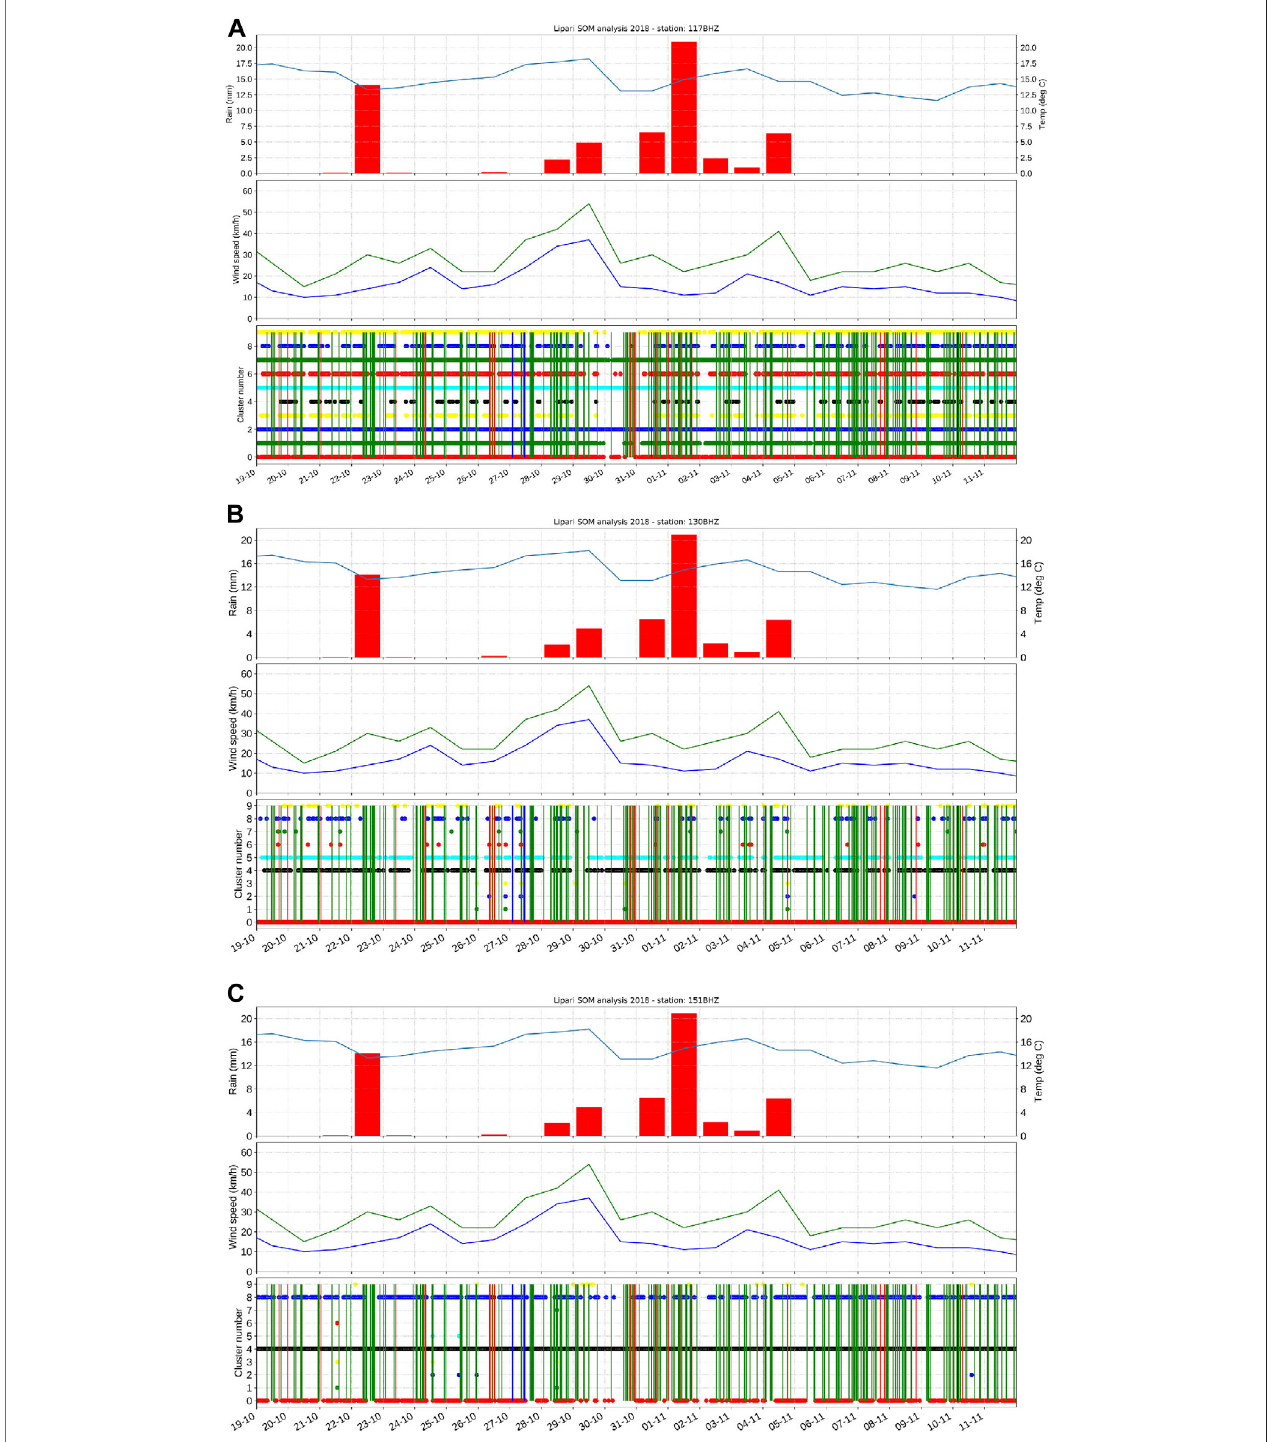
FIGURE 4 | 1-min long frames for stations 117 (top), 130 (middle) and 151 (bottom). Time evolution (horizontal axis) shows coherent appearance and disappearance of clusters, indicated by the number on the vertical axis. Cluster colors are only used to facilitate following their time evolution. Note the “ anomalous ” period of 30 October – 1 November 2018, where frames are mostly classi fi ed in only a few clusters. Cluster numbers do not correlate with weather data as shown in the top panels of each fi gure.